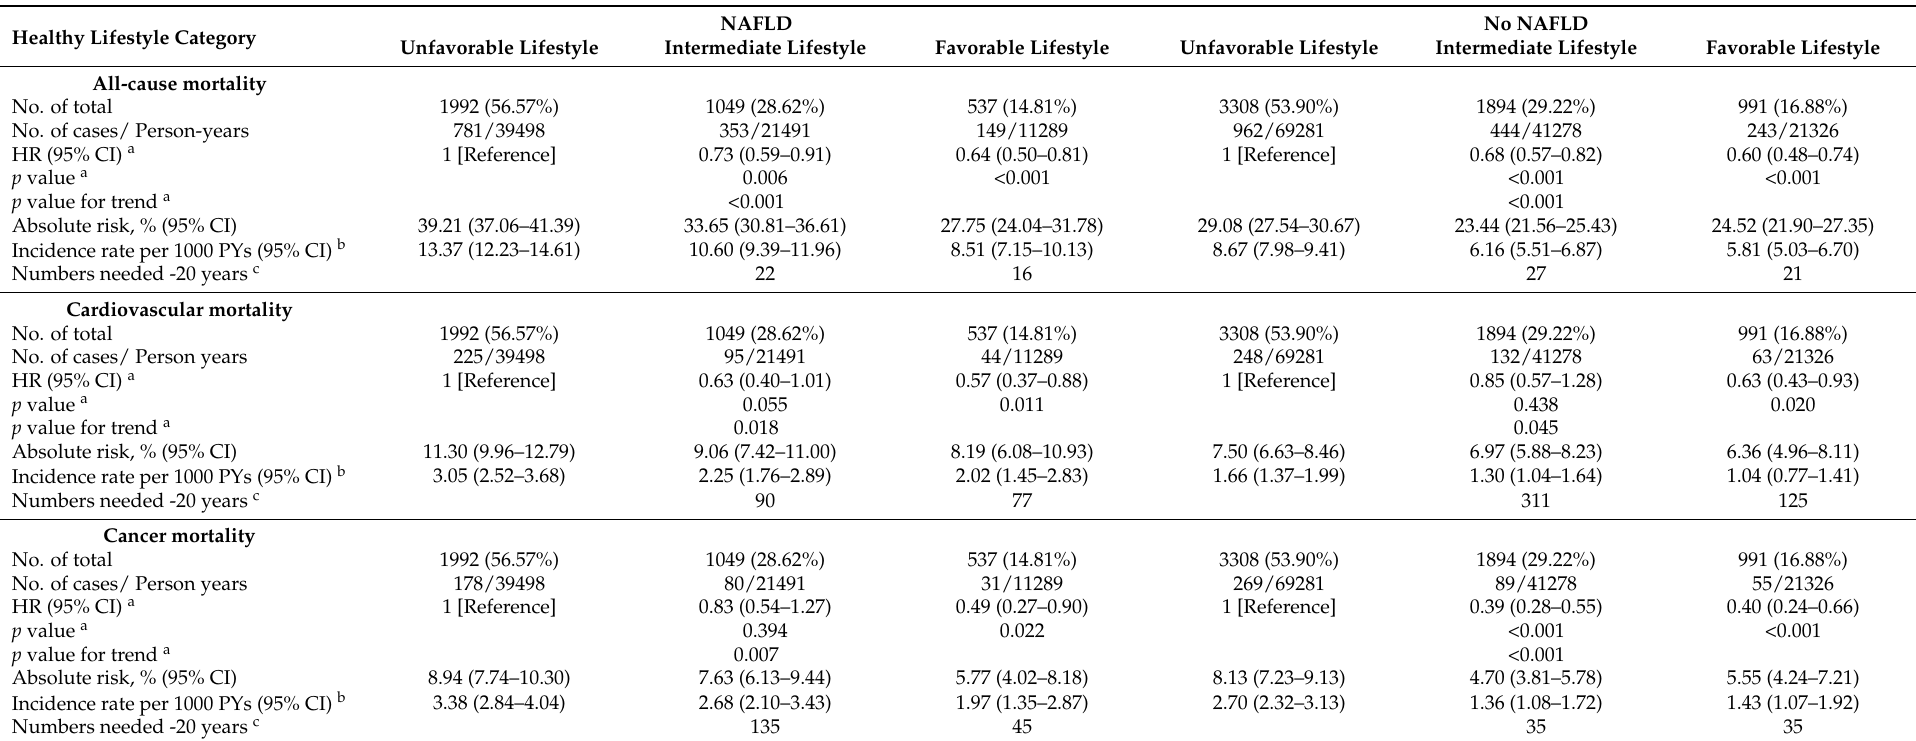
Table 2. Risk of mortality according to lifestyle